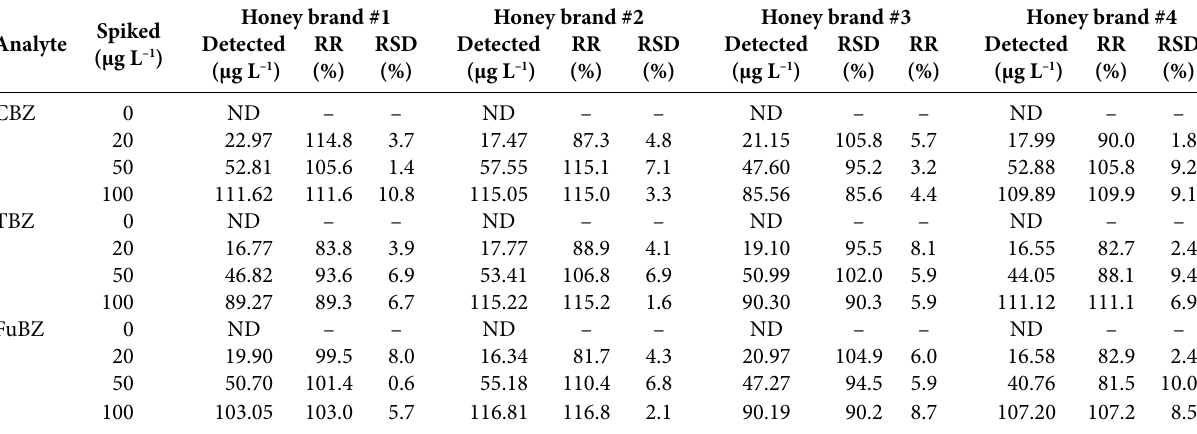
Table 3: Recovery obtained from the determination of benzimidazole fungicides in honey samples ( n = 3) Honey brand #1 Honey brand #2 Honey brand #3 Honey brand #4 Spiked